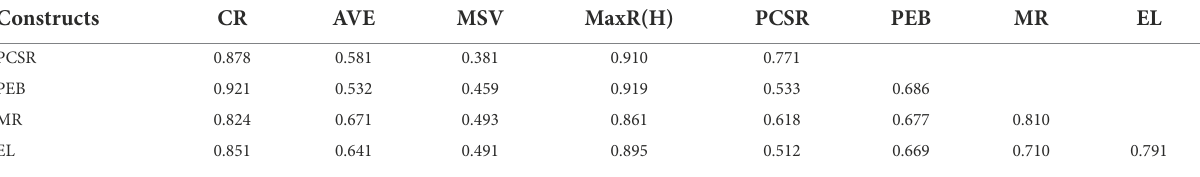
TABLE 7 Discriminant validity.